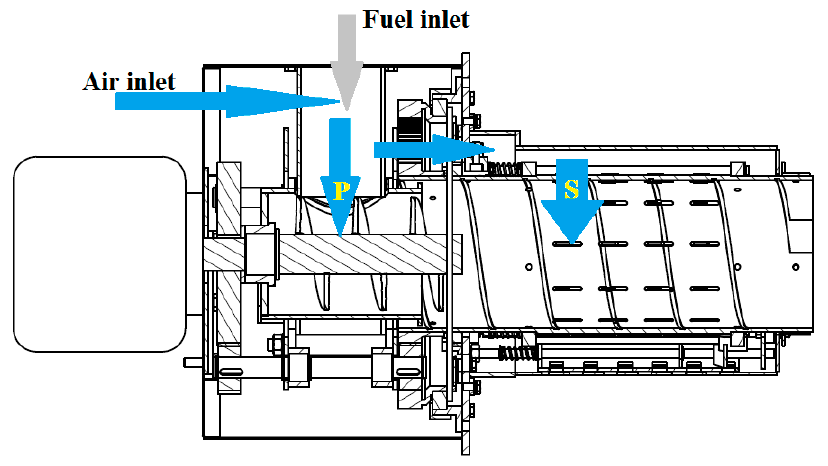
Figure 3. Air flow in proposed burner (P—primary air, S—secondary